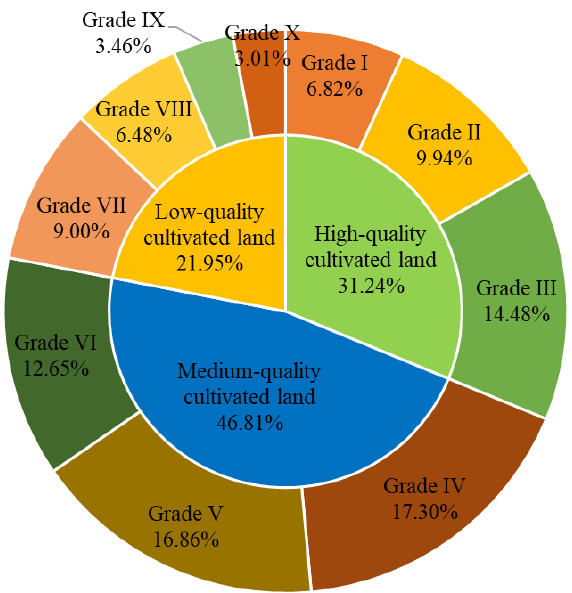
Figure 1. Statistics of China’s cultivated land quality grade in 2019.